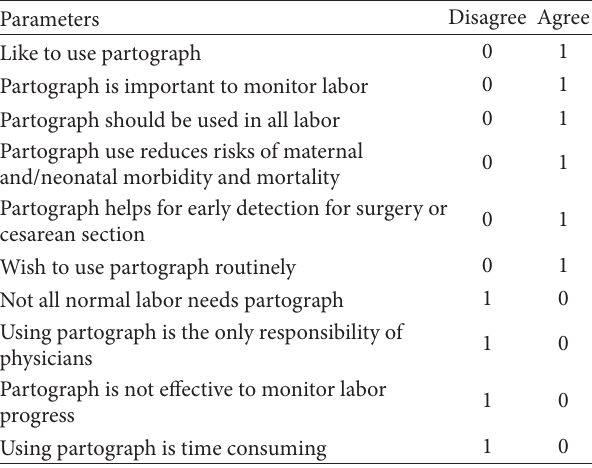
Table 2: Criteria for the partograph attitude